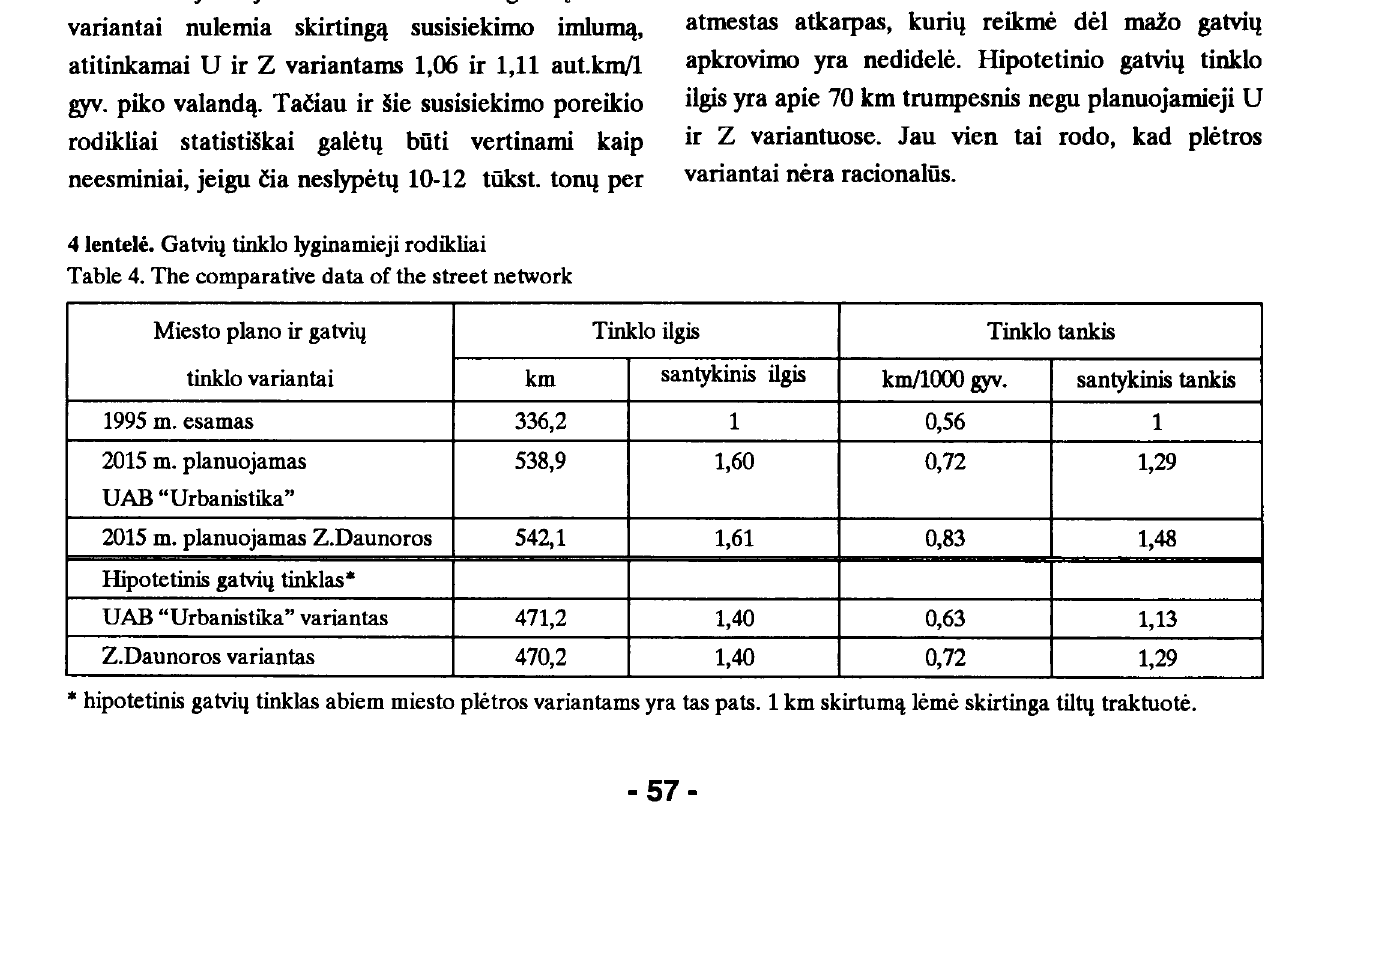
atmestas atkarpas, kuriq reikme del mafo gatviq ilgis yra apie 70 km trumpesnis negu planuojamieji U variantai nera